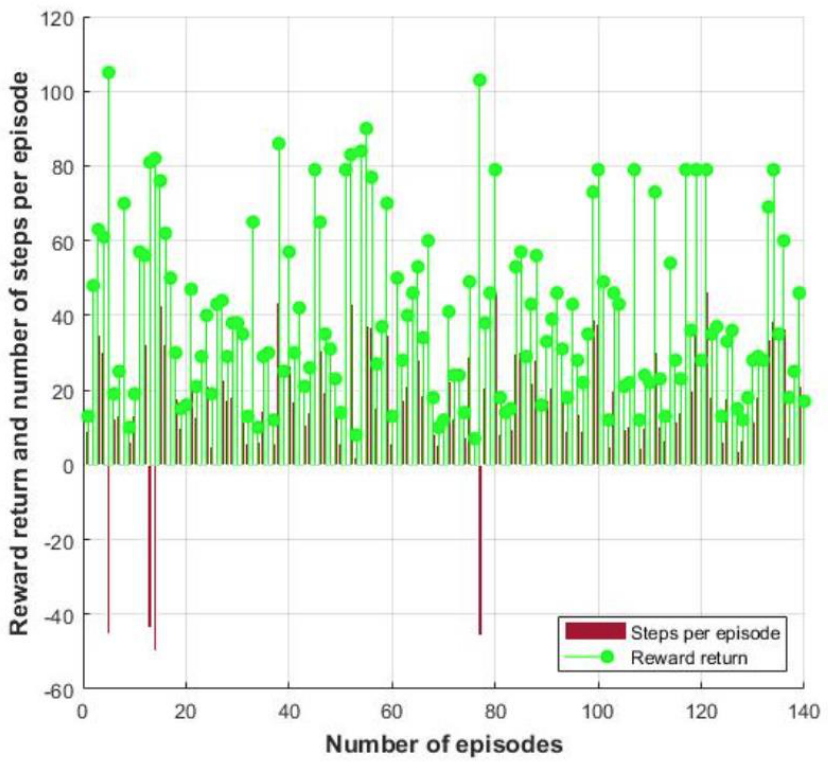
Figure 10. Accumulated reward returns per the number of steps in the second trip.